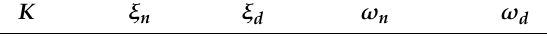
Figure 13. Identified model bode plots. Table 1. Parameters of the plant model.